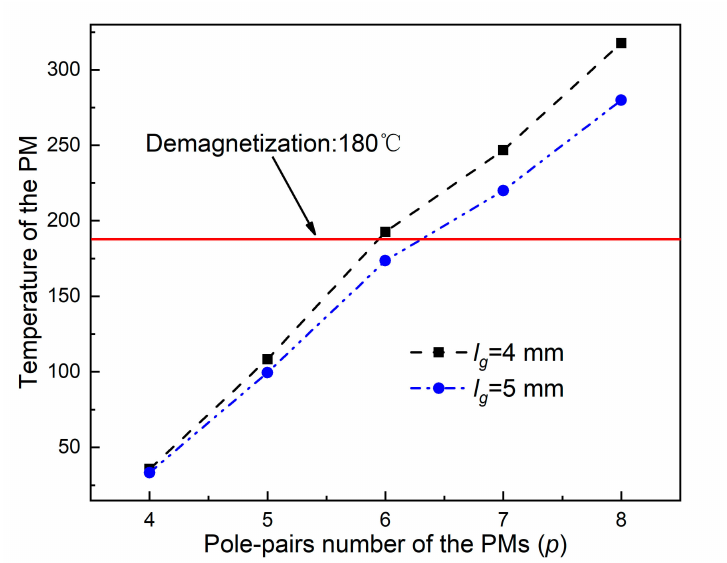
Figure 19. The relationship between the temperature of the PM and the pole-pairs number of the PMs. ( s = 120 r / min).